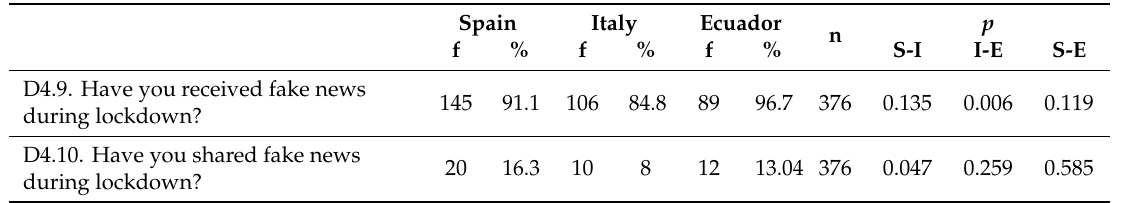
Table 6. Students reception and sharing of fake news during lockdown.